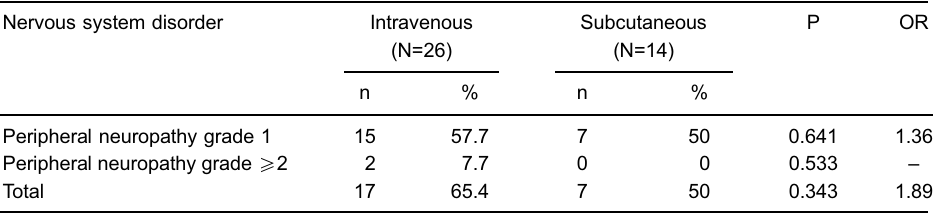
Table 6. Frequency of peripheral neuropathy according to the route of administration of bortezomib in multiple myeloma patients. Nervous system